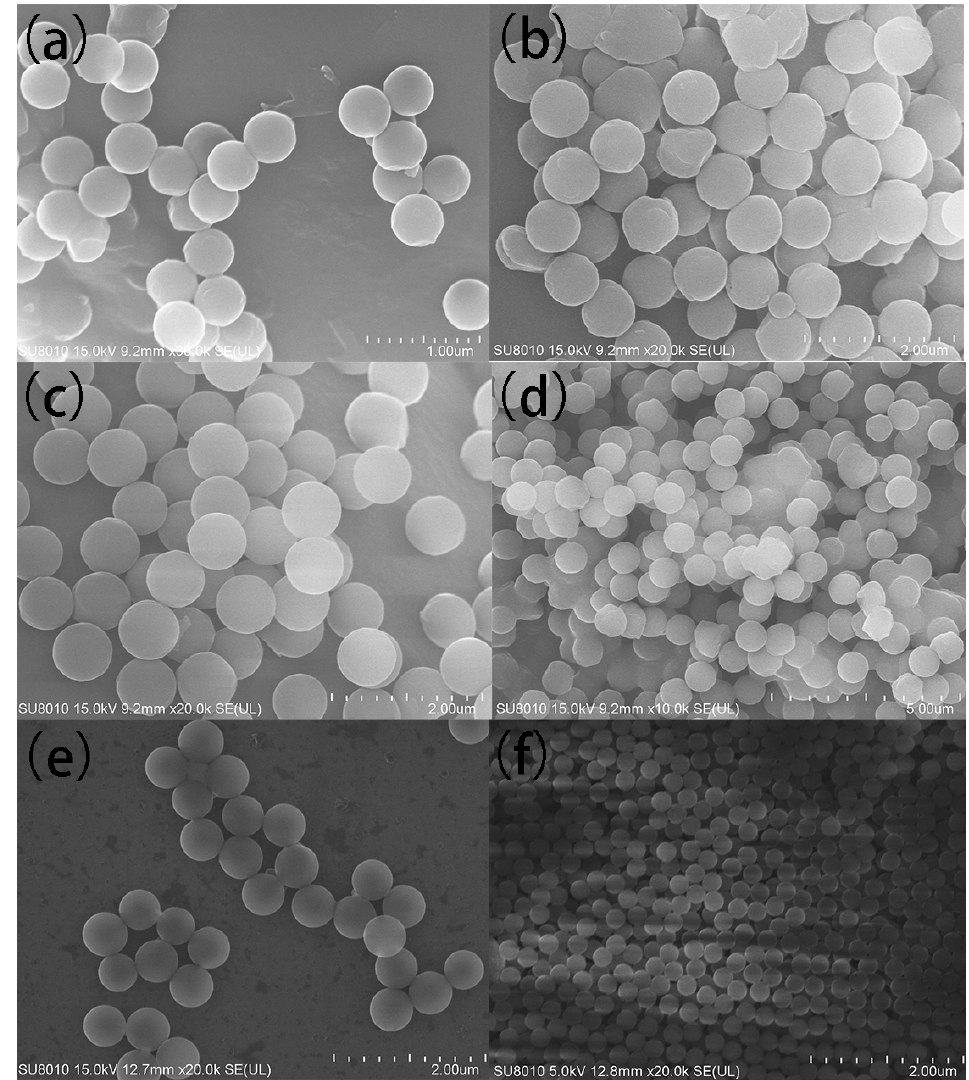
Figure 1. SEM images of polystyrene spheres at different concentration of KHCO 3 and C 8 H 7 SO 3 Na, (( a ), 4.5 mM/0.5 mM; ( b ), 7.5 mM/0.5 mM; ( c ), 10 mM/0.5 mM; ( d ), 17 mM/0.5 mM; ( e ), 17 mM/1 mM; ( f ), 17 mM/2 mM).